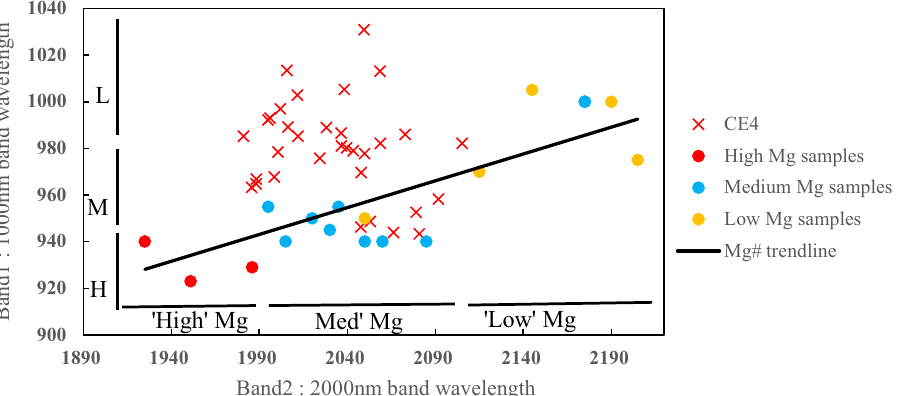
Figure 5. Comparison of the 1000 nm and 2000 nm band centers for spectra observed by Yutu-2 with the lunar highland and mare samples. The Mg # trend line was estimated using Apollo mare and highland samples. The Mg # of lunar samples were calculated using chemical information of MgO and